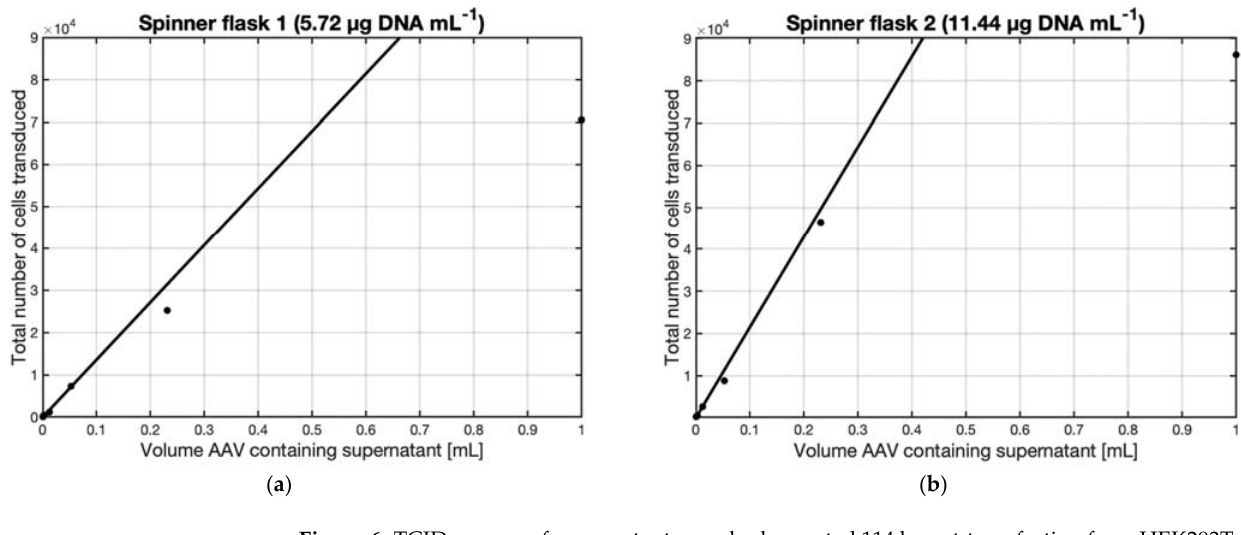
Figure 6. TCID 50 assay of supernatant samples harvested 114 h post-transfection from HEK293T cells immobilized on Cytodex 3 microcarriers transfected in 125 mL Bellco spinner flasks at a final concentration of ( a ) 5.72 µg DNA mL − 1 or ( b ) 11.44 µg DNA mL − 1 and a cell density of 1.4 × 10 6 cells mL − 1 , corresponding to spinner flasks 1 or 2 of Figure 5a; supernatant samples were serially diluted